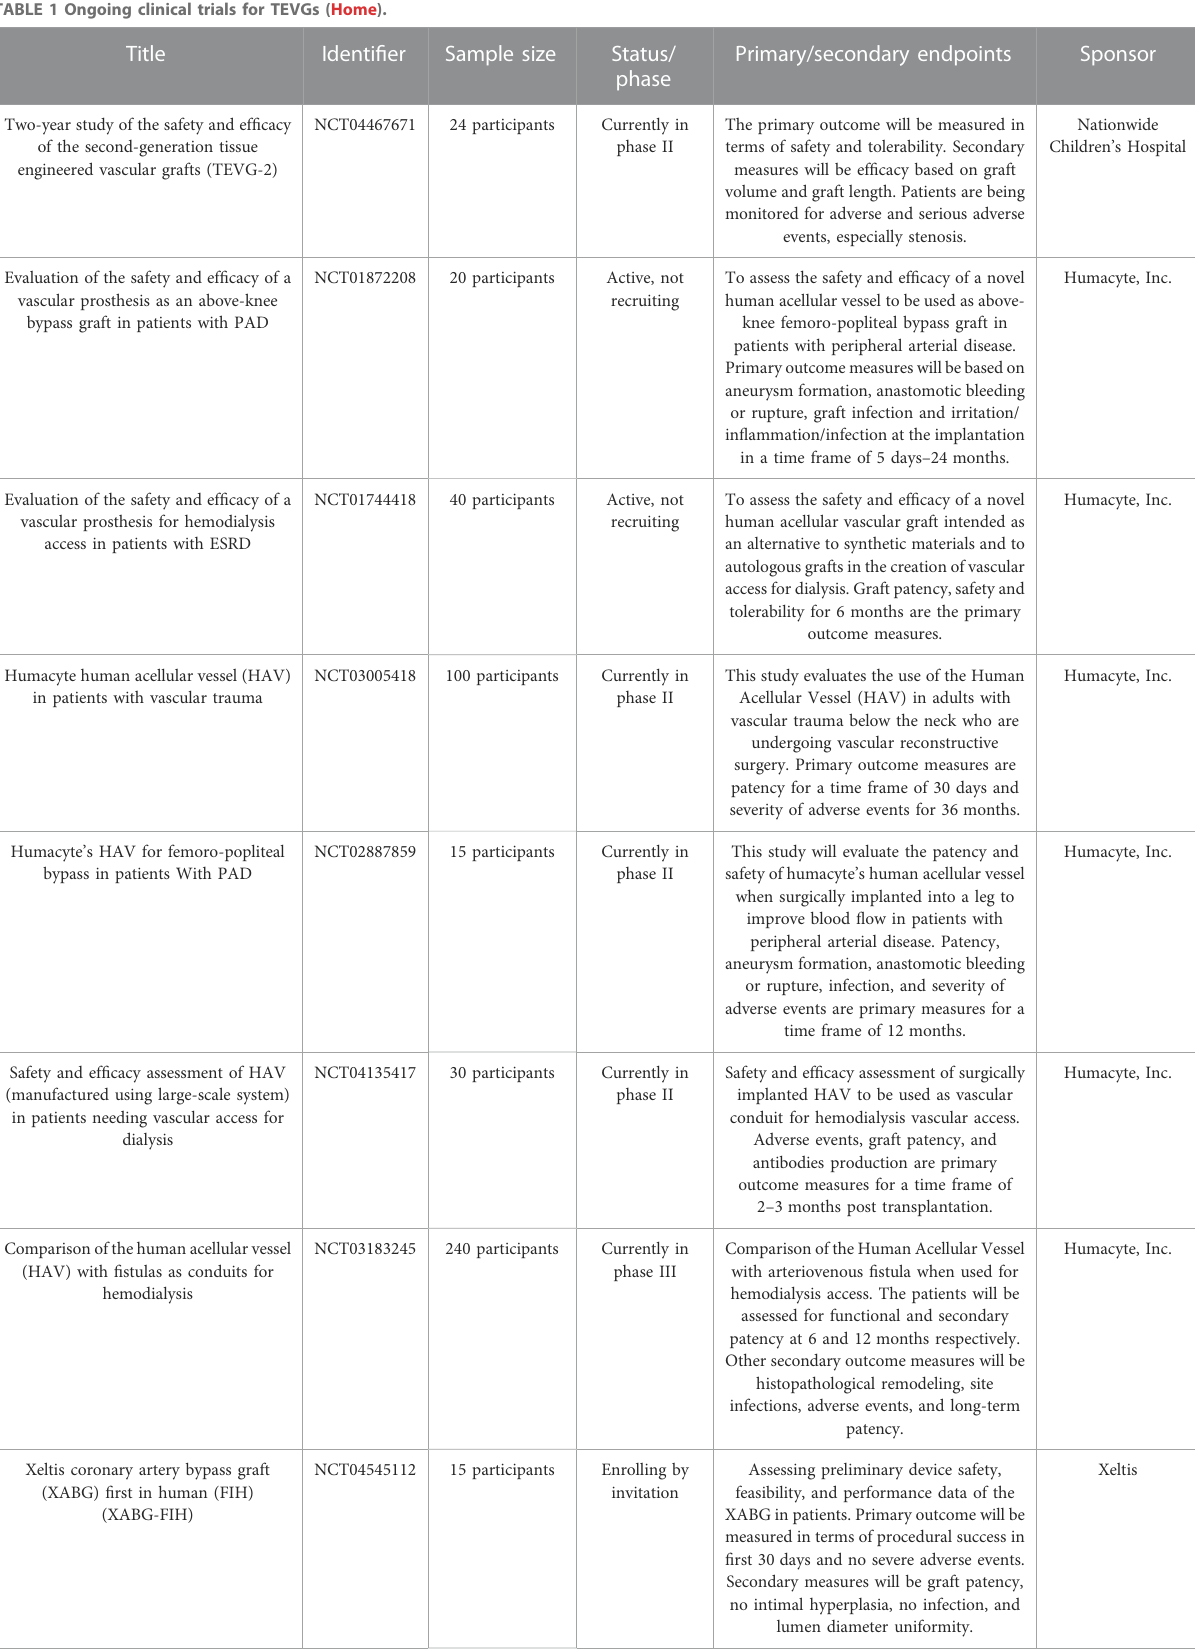
TABLE 1 Ongoing clinical trials for TEVGs